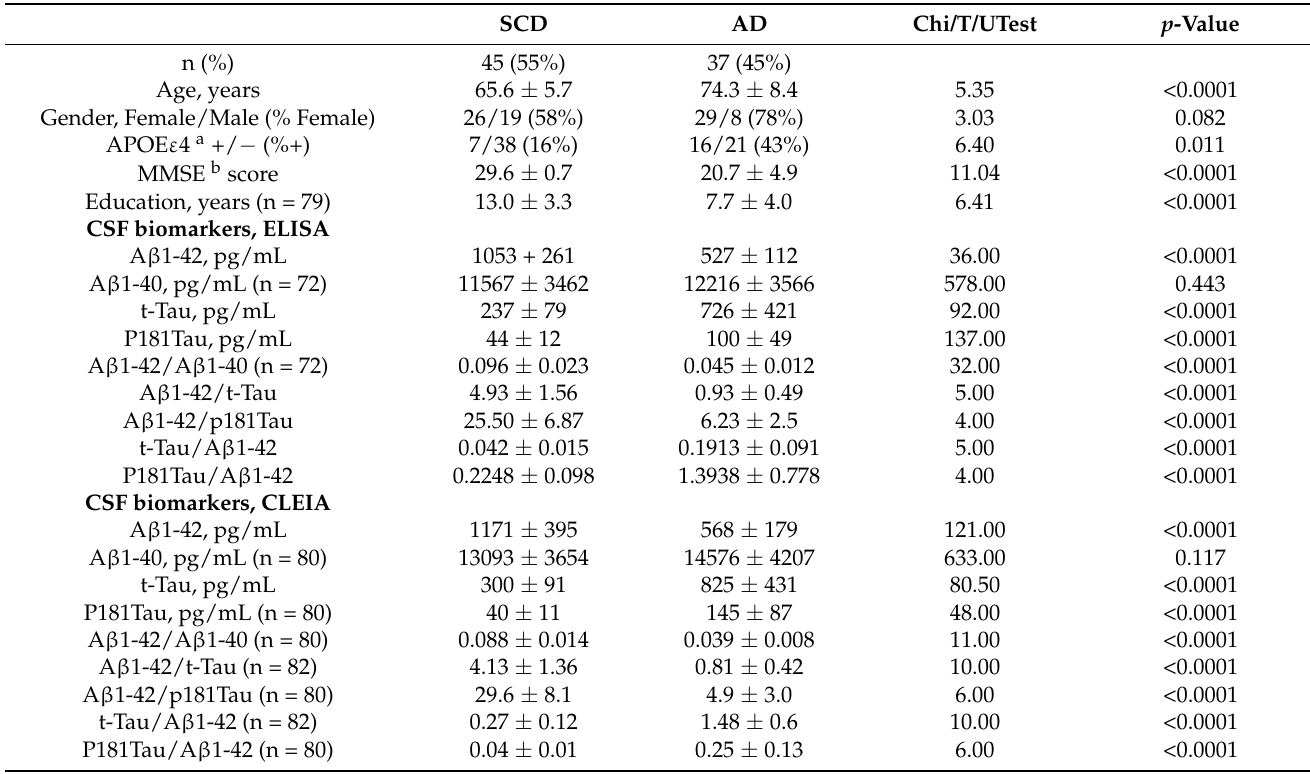
Table 1. Cutoff study: demographic, clinical, genetic, and biomarker data.